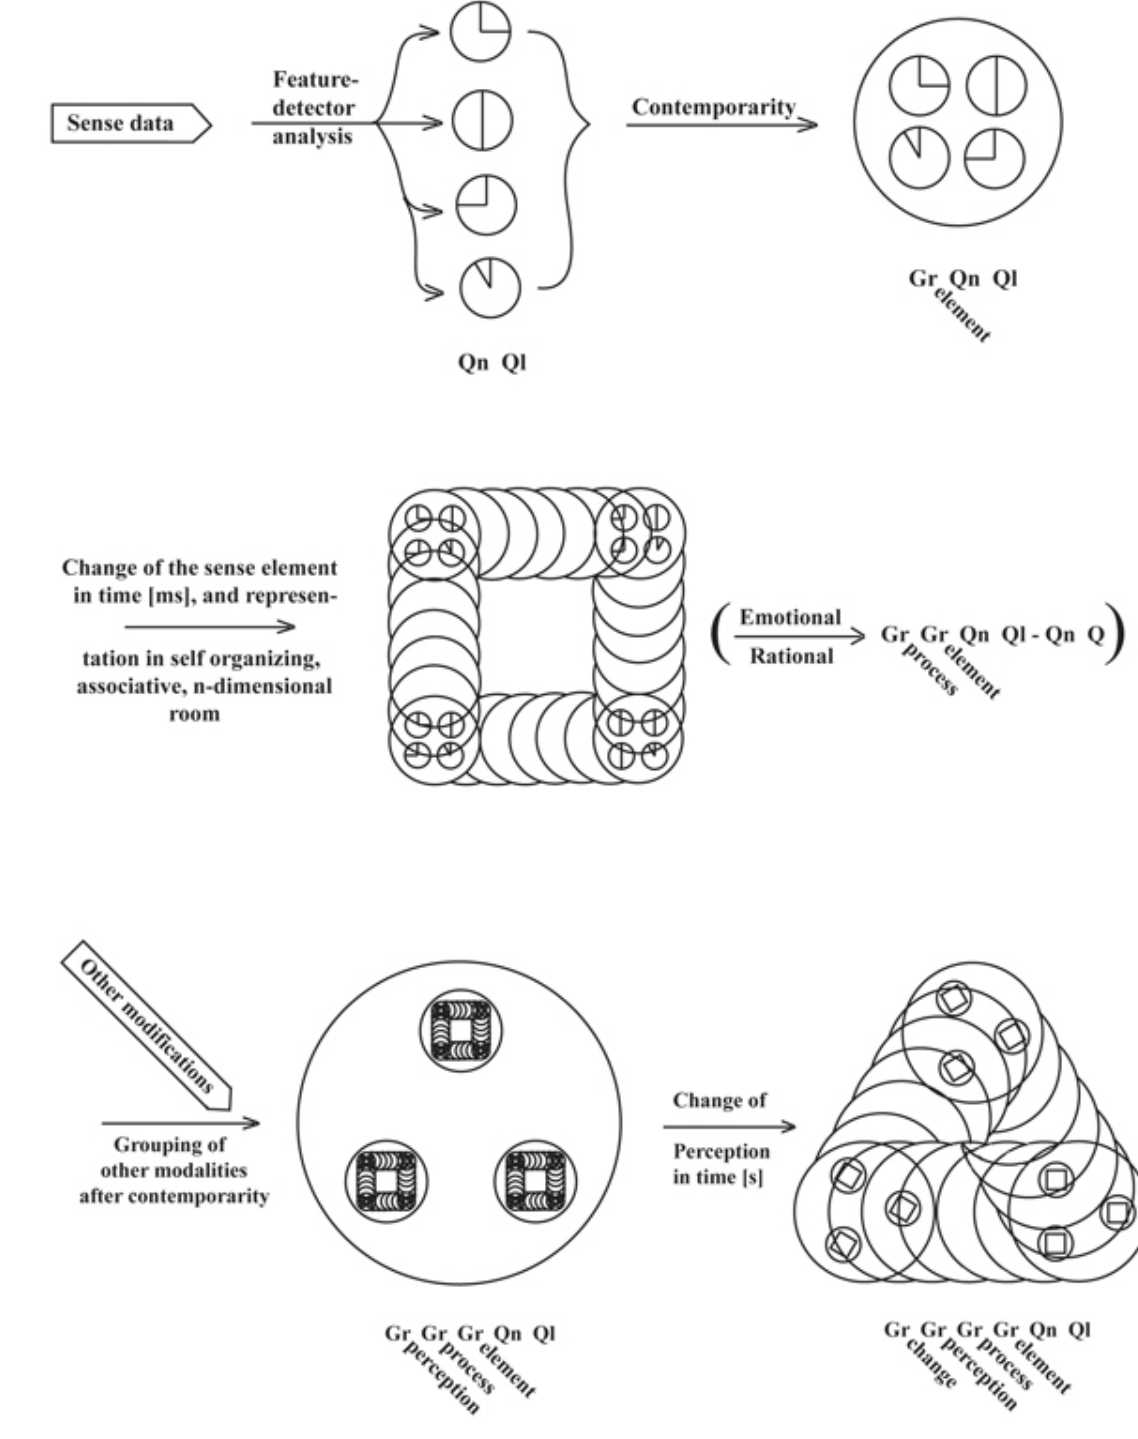
FIGURE 3. A model of the representation of reality in the human brain (see text). Continues next